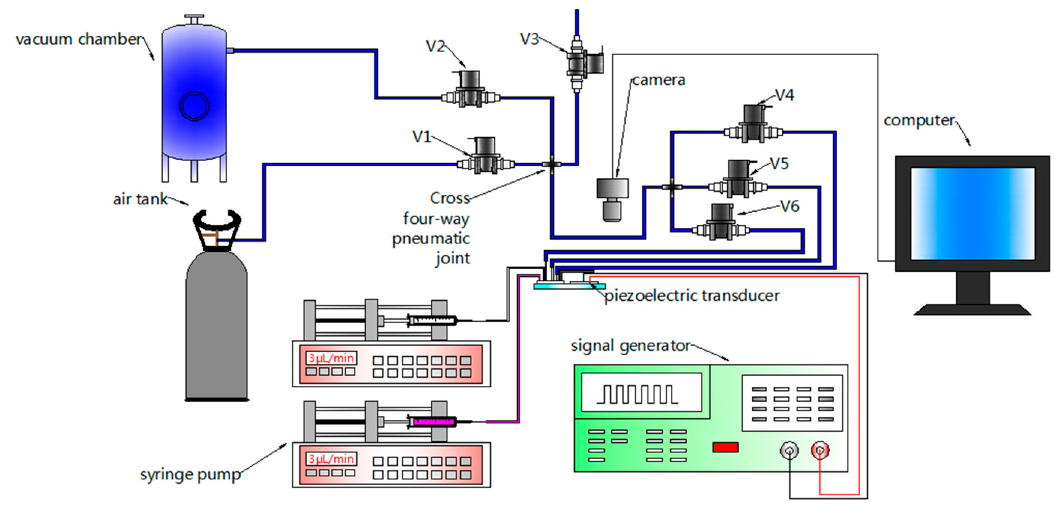
Figure 4. Schematic of the experimental setup for testing.